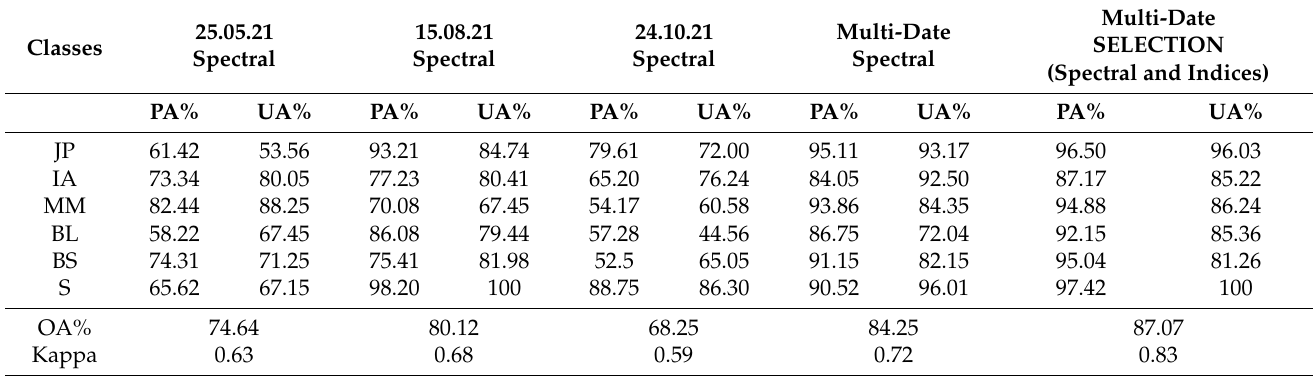
Table 5. Comparison of classification accuracies of tree species for single date, multi-date, and multi-feature